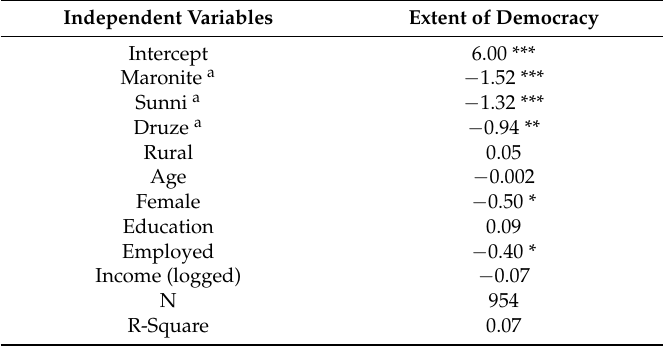
Table 5. Results from OLS Regression Model Predicting Evaluations of the State of